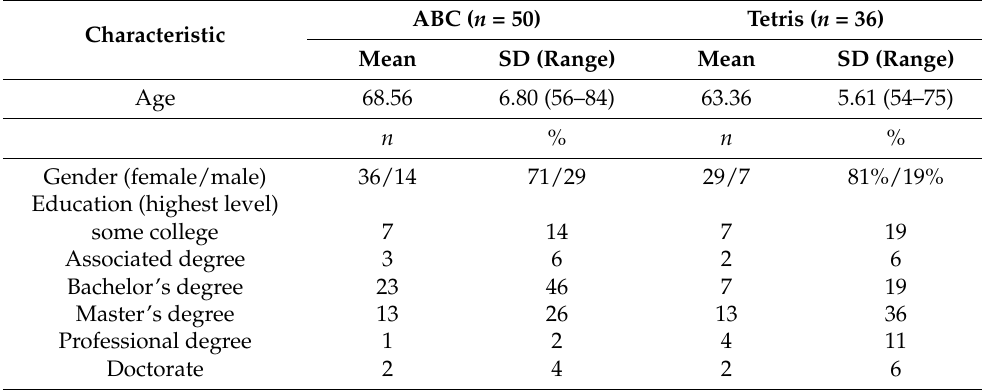
Table 1. Sociodemographic characteristics of the sample by group (treatment vs.